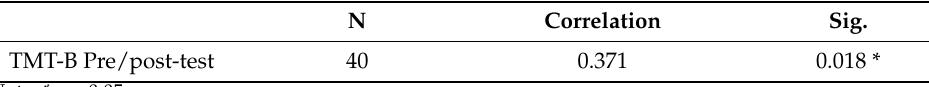
Table 20. Paired sample test of TMT-B.